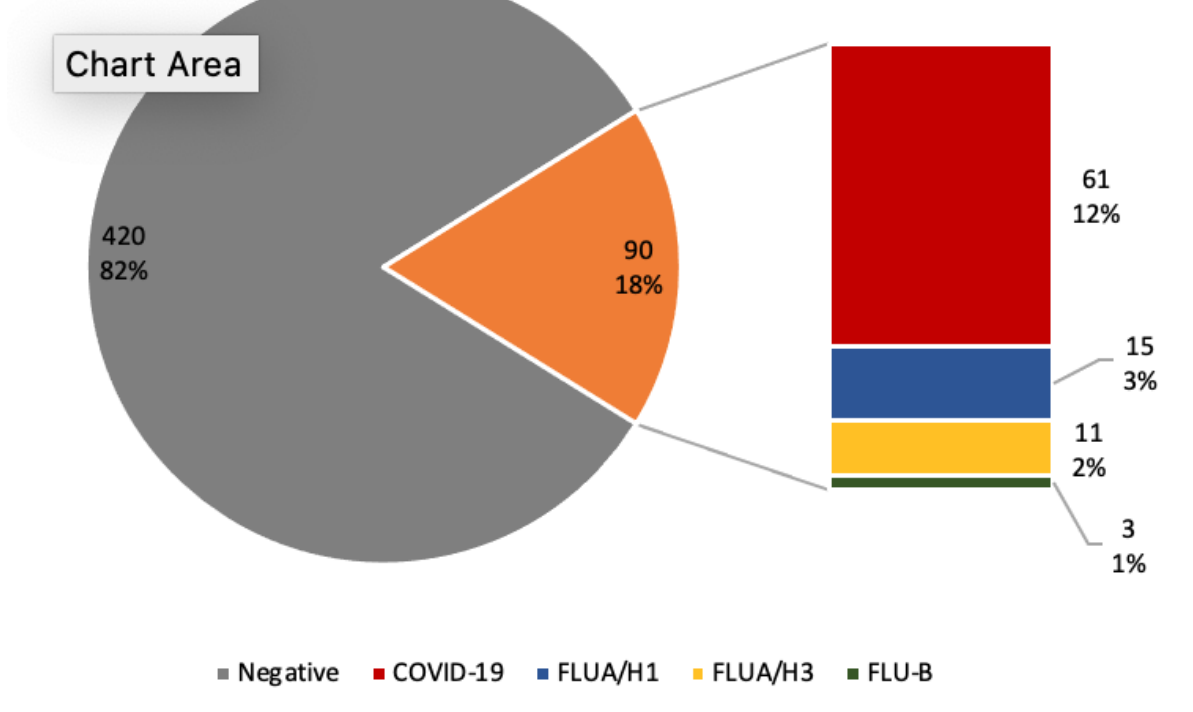
Figure 1. Viral causes of 510 specimens collected from influenza-like illness sentinel surveillance in Egypt from October 2019 to September 2020. FLUA/H1: influenza A(H1N1); FLUA/H3: influenza A(H3N2); FLU-B: influenza